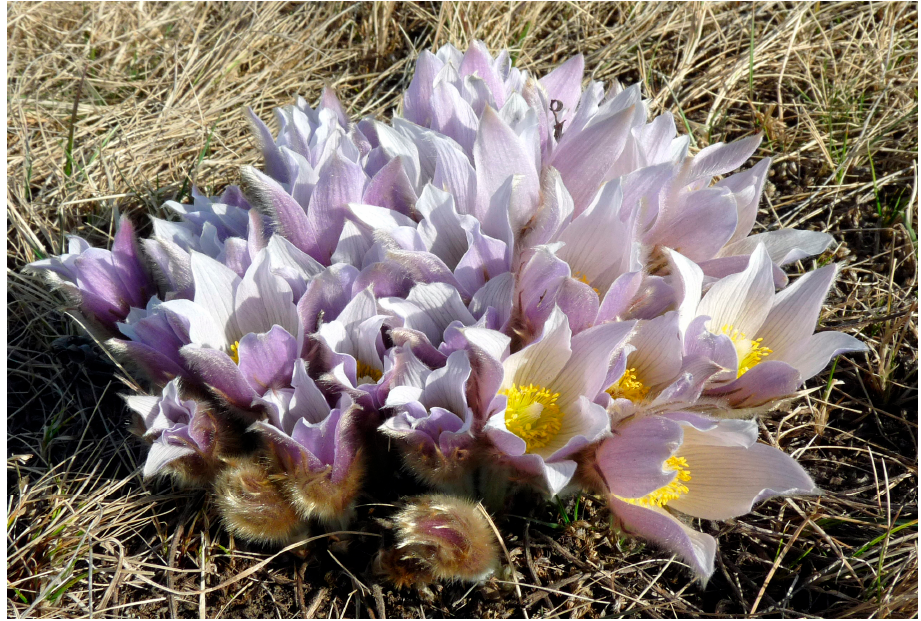
Figure 4. The largest clump recorded for A. patens growing in the Crocus Prairie Conservation Area (Saskatoon, Saskatchewan). Photo by Vladimir Kricsfalusy.